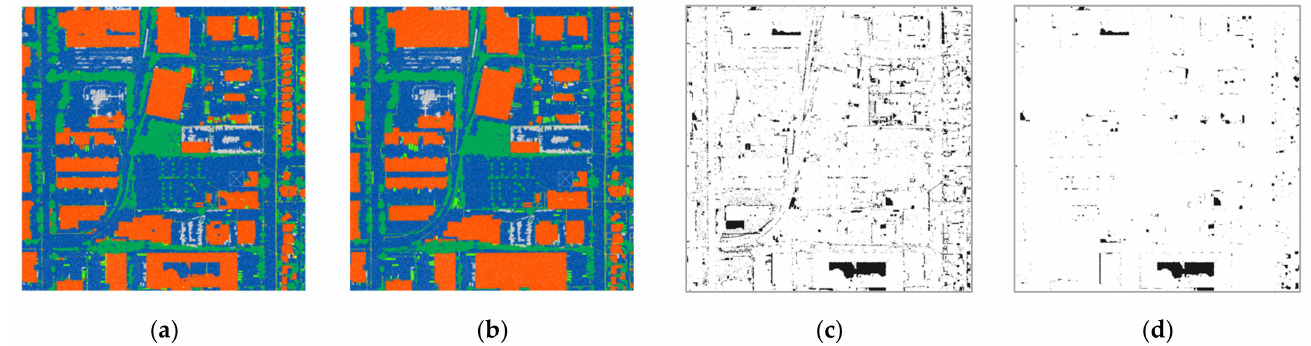
Figure 21. Results of semantic segmentation of test data 2 for Case 3: ( a ) prediction; ( b ) ground truth (i.e., label data); ( c ) difference between prediction and ground truth for all classes; ( d ) difference between prediction and ground truth for building class